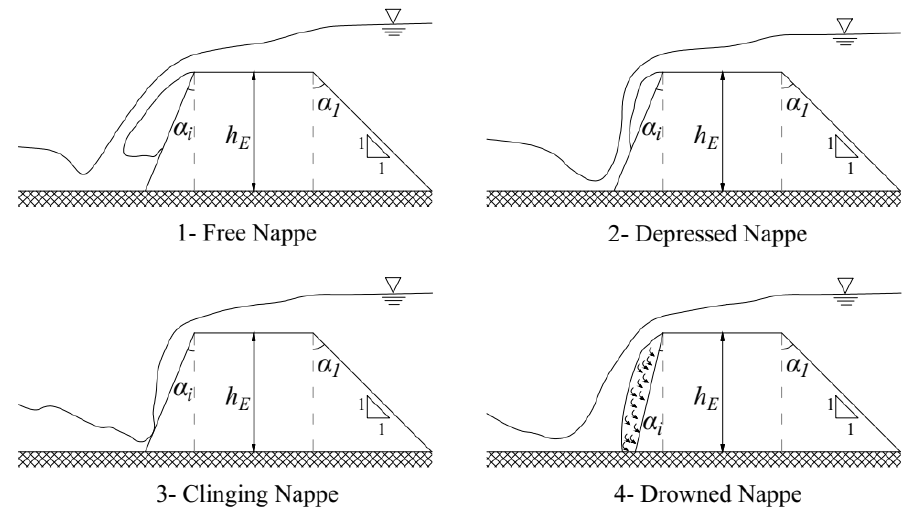
Figure 4. Schematic diagram of types of nappe